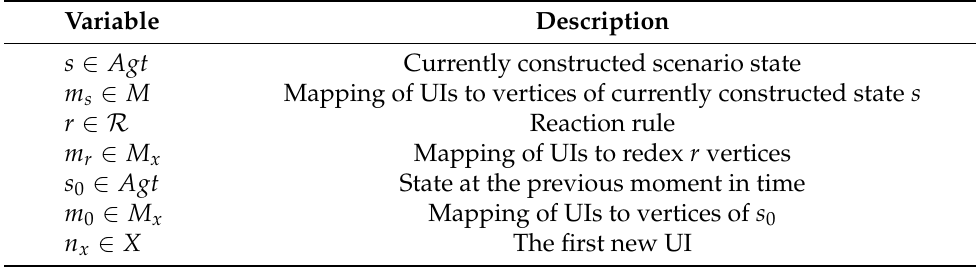
Table 5. Input data for the Phase 4